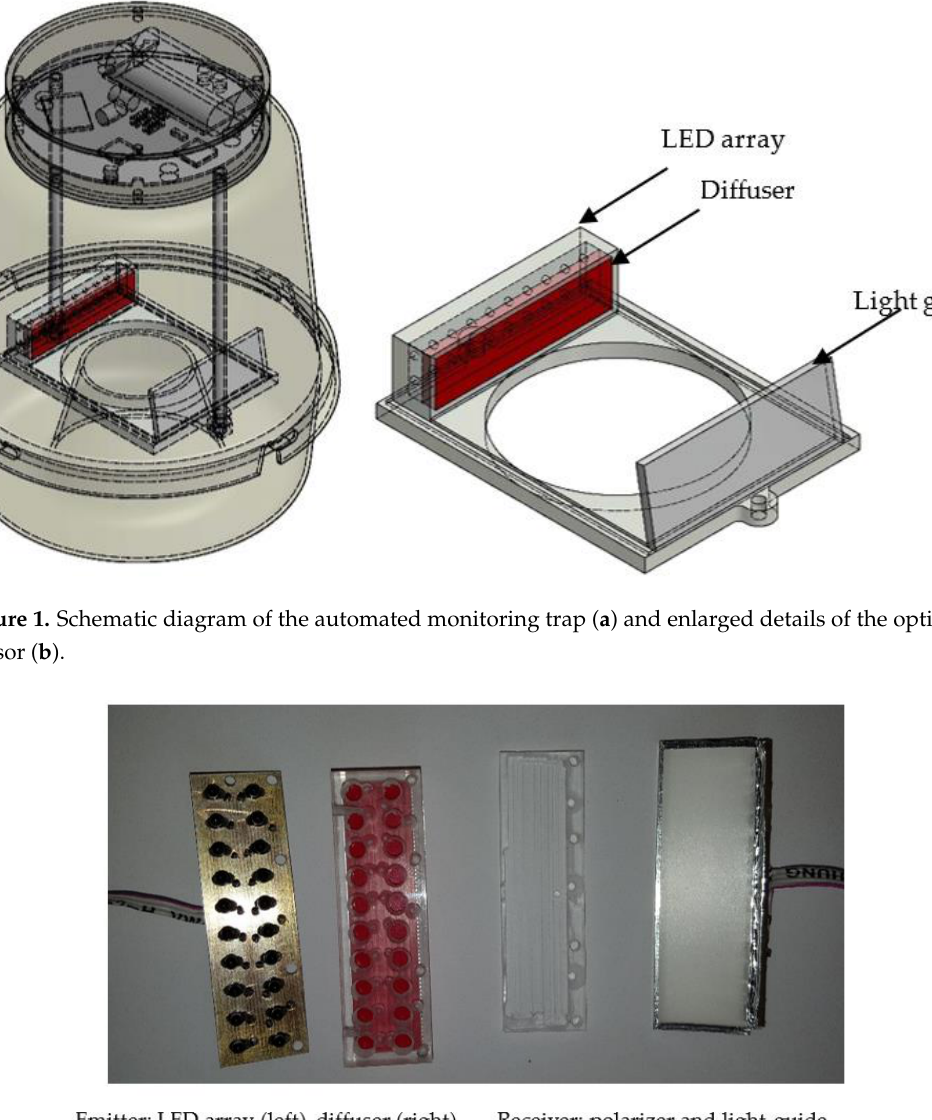
Figure 2. Sensor. The first two items on the left compose the emitter and the other two on the right, the receiver.